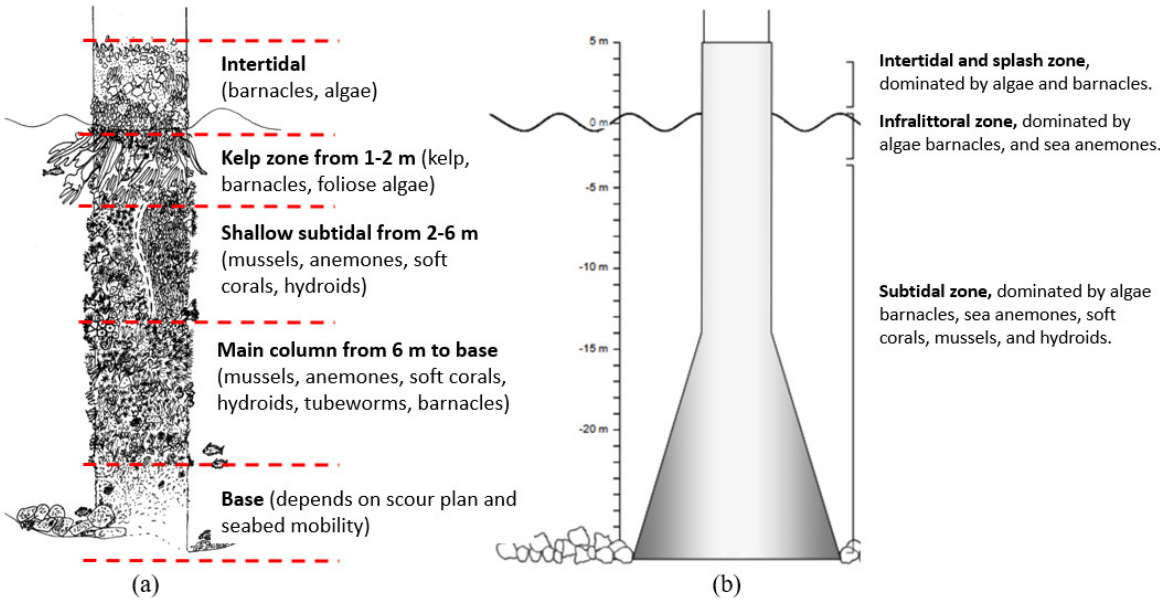
Figure 2. Schematic view of zonal communities and vertical distribution likely on offshore structures in the southern North Sea adopted from ( a ) [7]; ( b ) [9,10].